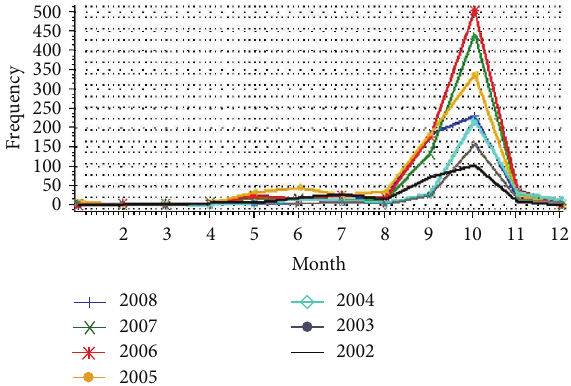
Figure 9: Monthly average fire counts over the Nile Delta during 2002–2009 courtesy of Marey et al., 2010 [26].